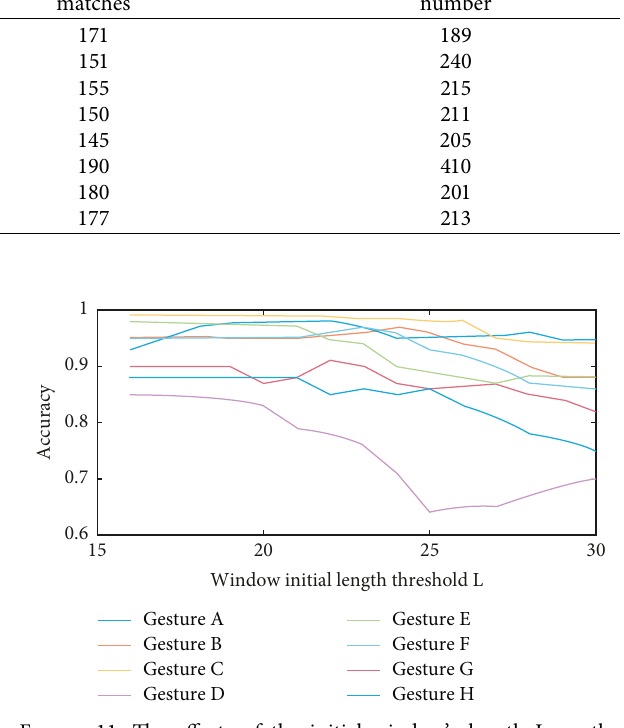
Figure 11: The effects of the initial window’s length L on the